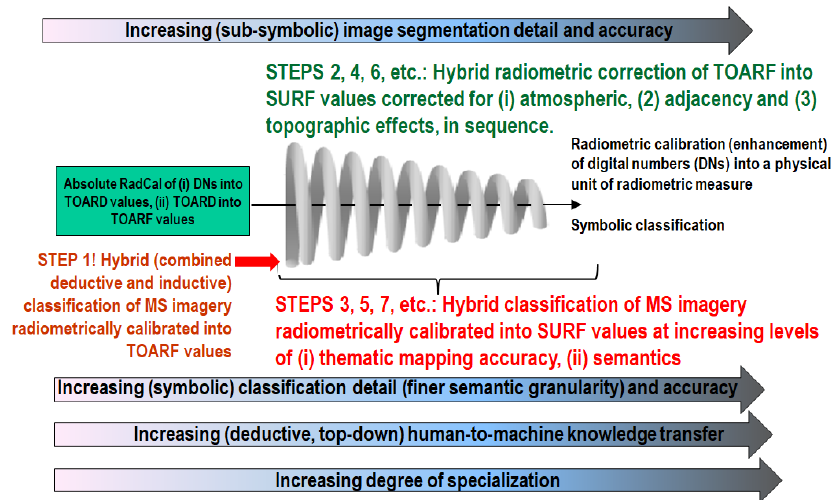
Figure 12. Ideal ESA EO Level 2 product generation design as a hierarchical alternating sequence of: (A) hybrid (combined deductive and inductive) radiometric enhancement of multi-spectral (MS) dimensionless digital numbers (DNs) into top-of-atmosphere reflectance (TOARF), surface reflectance (SURF) values and spectral albedo values corrected in sequence for (1) atmospheric, (2) adjacency, (3) topographic and (4) BRDF effects, and (B) hybrid (combined deductive and inductive) classification of TOARF, SURF and spectral albedo values into a sequence of ESA EO Level 2 scene classification maps (SCMs), whose legend (taxonomy) of community-agreed land cover (LC) class names, in addition to quality layers cloud and cloud–shadow, increases hierarchically in semantics and mapping